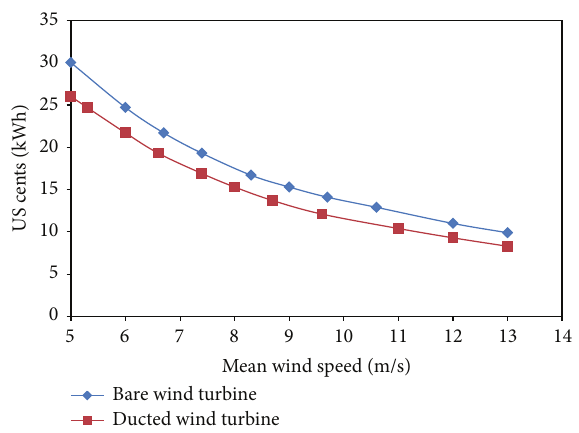
Figure 3: LUCE for the DSWES and SWES for varying mean wind speeds.